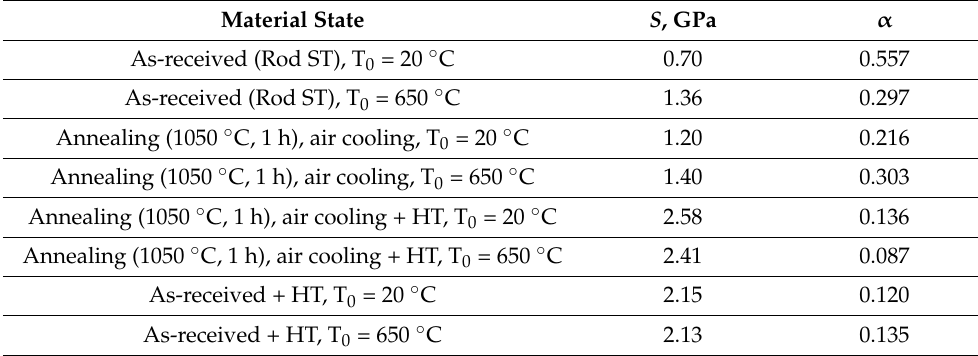
Table 4. Coefficient S and power exponent α of the approximating function